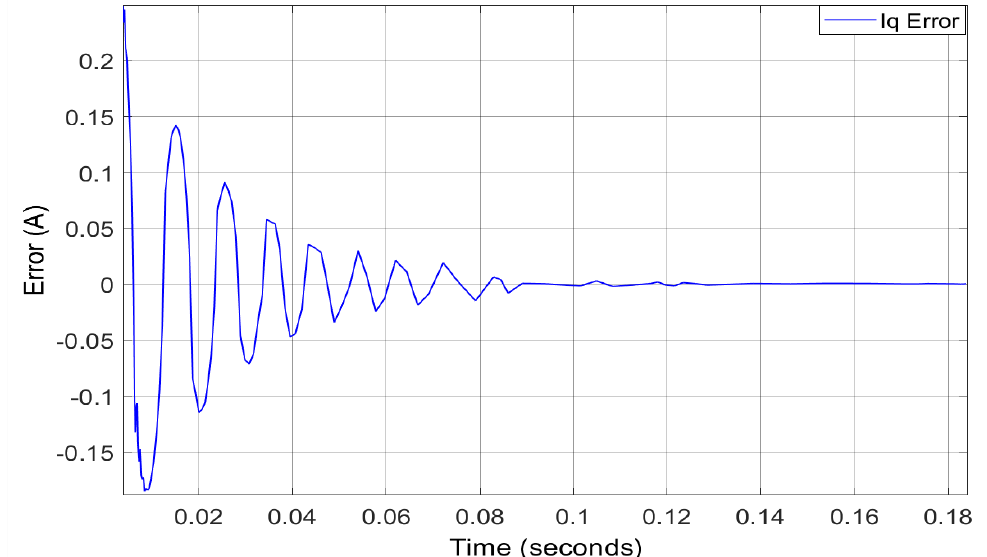
Figure 12. Stator current in q-axis error at the nominal temperature of 20 ◦ C.